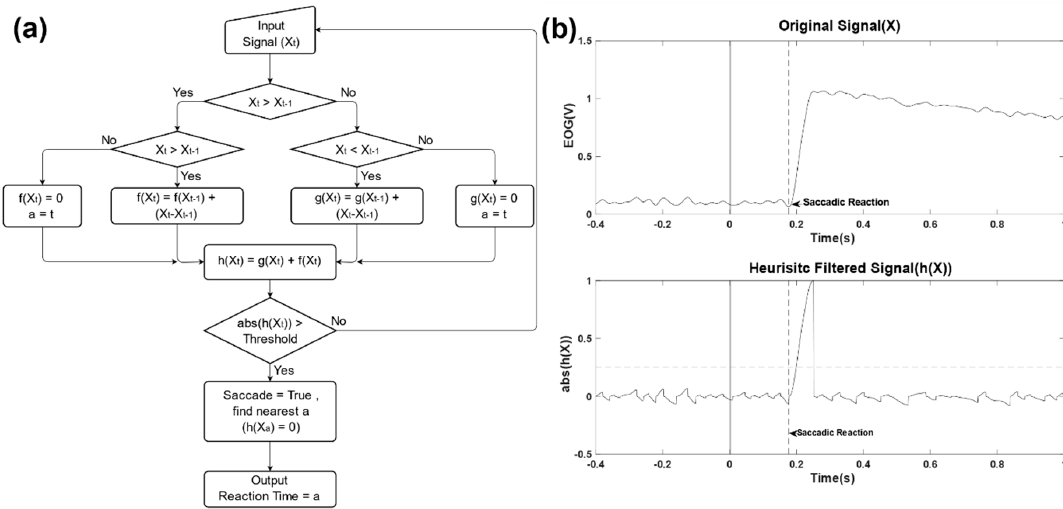
Figure 2. ( a ) Flow chart of the heuristic filter. Xt was noise removed signal from the original signal, h(Xt) was monotonic changed signal, and RT was Reaction Time when saccade occurred after target moved. ( b ) Example plots of original signal and heuristic filtered signal. The vertical solid line in original signal indicates when the target moved, and the vertical dotted line indicates RT. The horizontal dotted line in the heuristic filtered signal indicates a threshold for saccade detection, and the horizontal arrow indicates the point at which the saccadic reaction occurred.